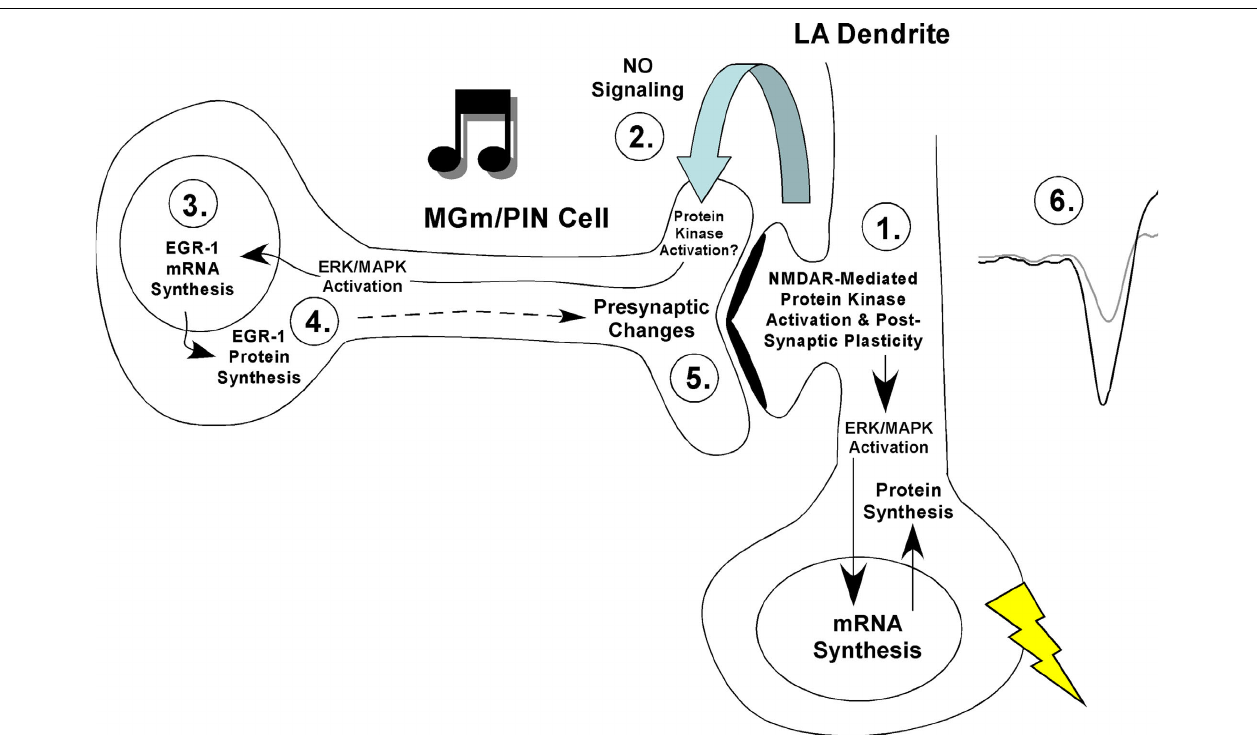
which can in turn engage ERK-dependent signaling and transcription in MGm/ PIN neurons (Step 3). ERK-driven gene expression in MGm/PIN neurons (Step 4) is, in turn, hypothesized to promote presynaptic functional and/or structural changes at thalamo-LA synapses (Step 5). Together with the postsynaptic modifi cations driven by ERK signaling in the LA, these presynaptic modifi cations act to strengthen the connectivity of thalamo-LA synapses, which is refl ected neurophysiologically in an enhanced response to the CS in the LA after training (Step